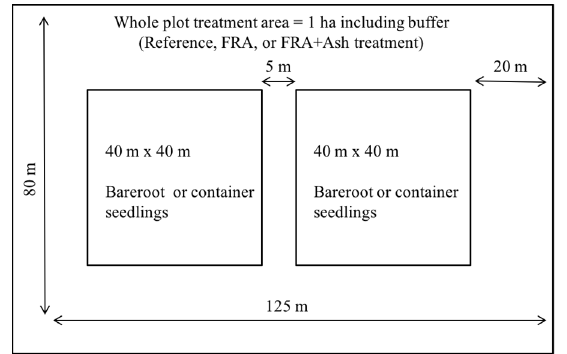
Figure 1. Example of an experimental unit where soil reclamation treatments (Reference is the standard mine reclamation technique, FRA is the modified Forestry Reclamation Approach, and FRA + Ash is the modified Forestry Reclamation Approach with an addition of bottom ash from the on-site coal burning power plant.) are applied to the whole plot treatment area and bareroot or container Douglas-fir seedlings to nested split plots. Three 10 m by 10 m subplots were randomly located within each split-plot for